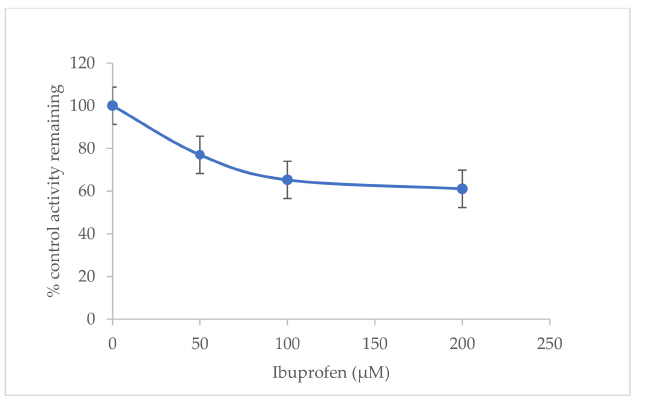
Figure 6. Inhibition of CYP3A2 enzyme activity by ibuprofen (0 − 200 µ M) in rat liver microsomes. Values are expressed as the average of triplicate measurements. Control activity was taken as 100%. Table 2. Pharmacokinetic parameters for inhibition patterns of CYP3A2 isoenzyme in the presence of dexamethasone substrates and Ibuprofen (inhibitor). The mean of three experiments is taken ± SD ( n = 3). Note: p < 4.653 × 10 − 7